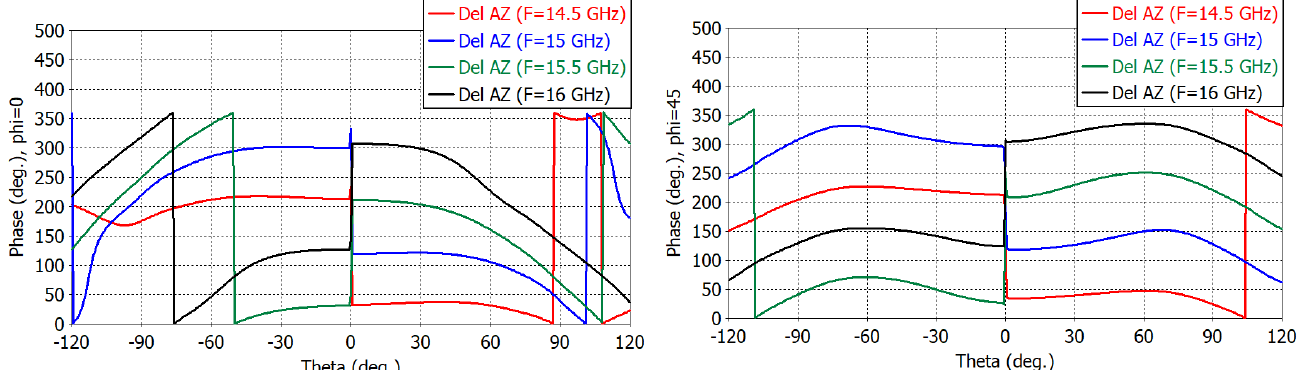
Figure 11. Phase patterns of the azimuth difference channel.